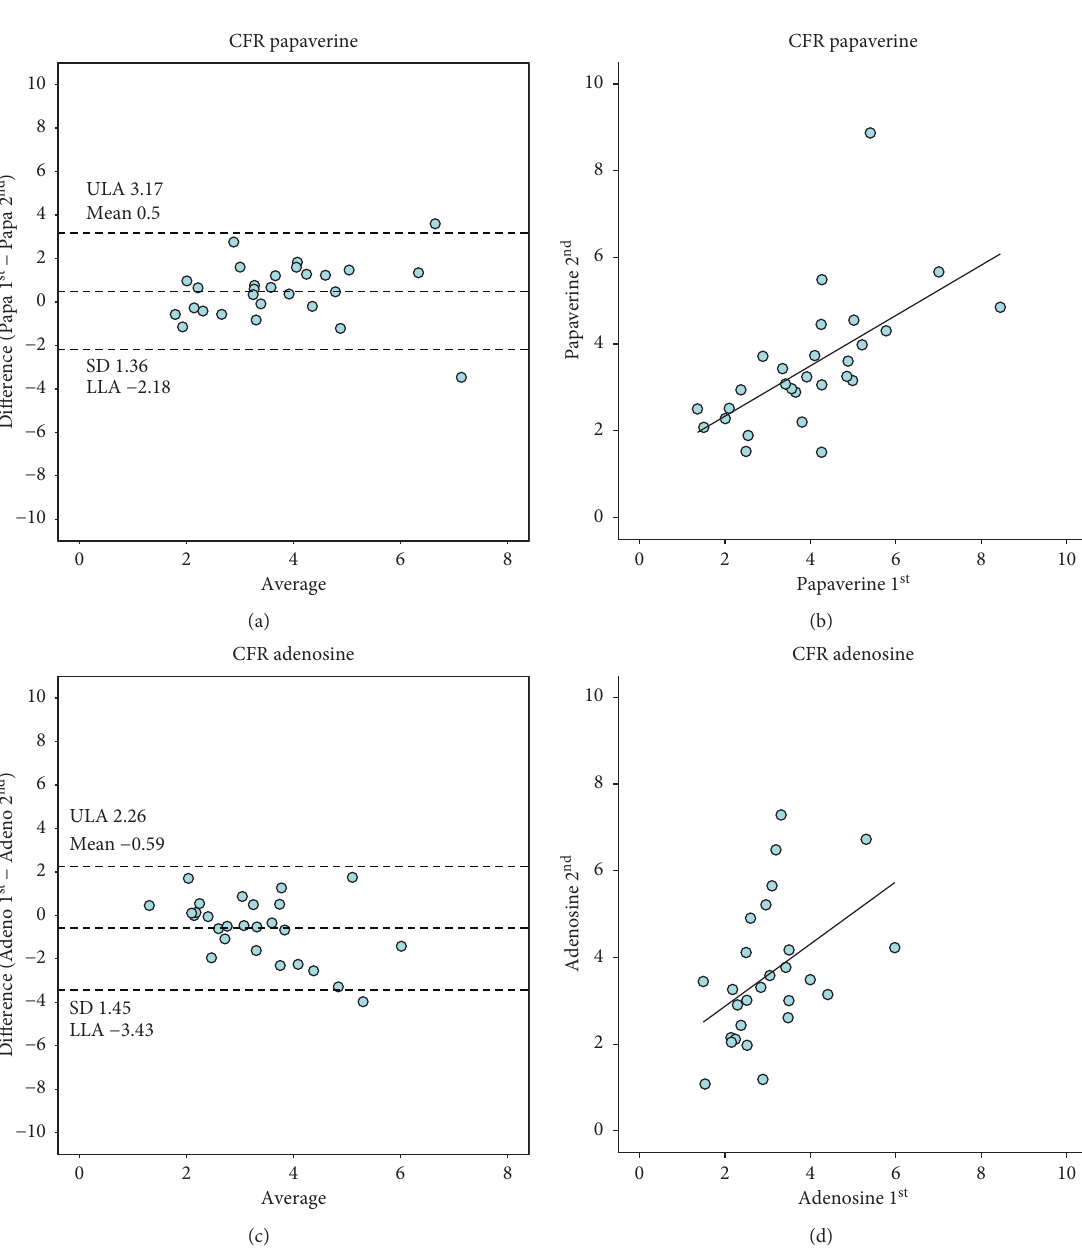
Figure 3: Reproducibility of CFR obtained with IC papaverine and IV adenosine. (a) Bland–Altman plot of CFR with repeated measures of papaverine. (b) Correlation of CFR measured with repeated measures of papaverine. (c) Bland–Altman plot of CFR measured with repeated measures of adenosine. (d) Correlation of CFR measured with repeated measures of adenosine. IMR, index of microvascular resistance; IC, intracoronary; IV, intravenous; Papa 1 st , first injection of papaverine; Papa 2 nd , second injection of papaverine; Adeno 1 st , first injection of adenosine; Adeno 2 nd , second injection of